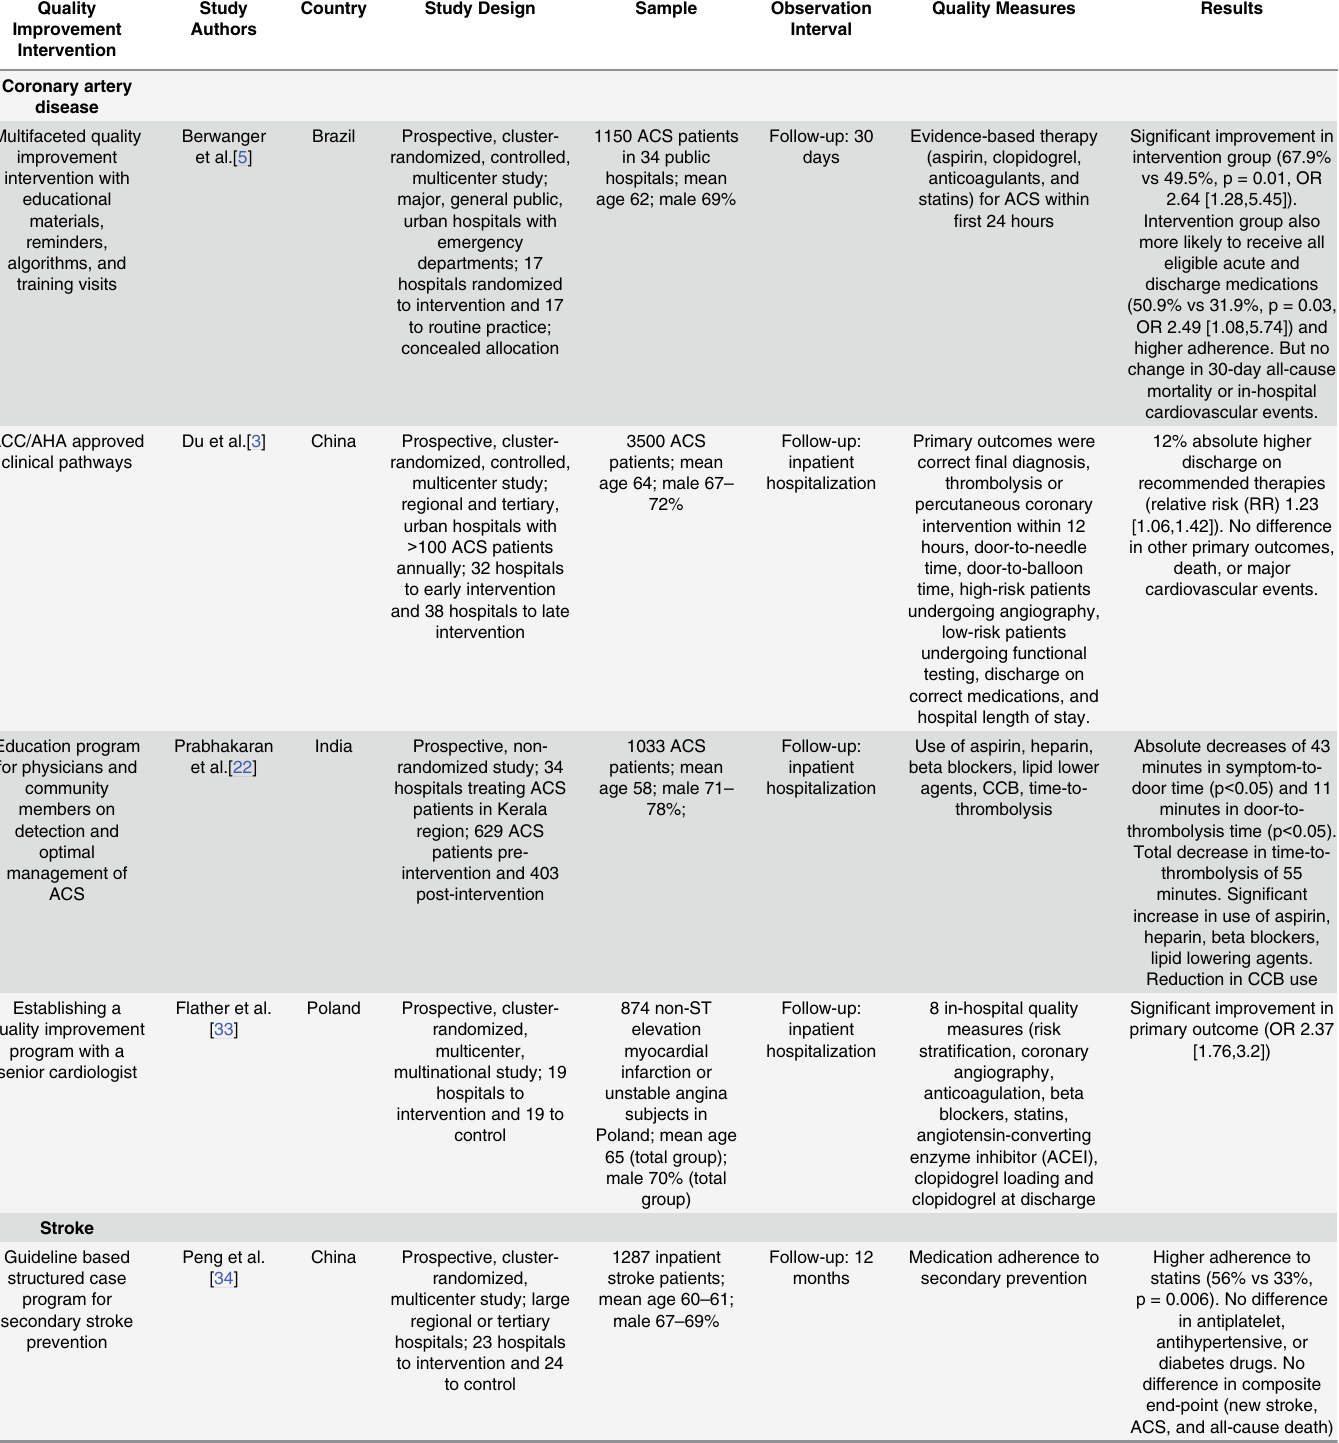
Table 4. Patient/provider level-acute phase CVD quality improvement studies identified during